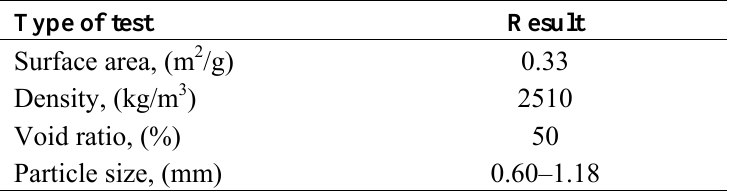
Table 2. Physical characteristics of silica